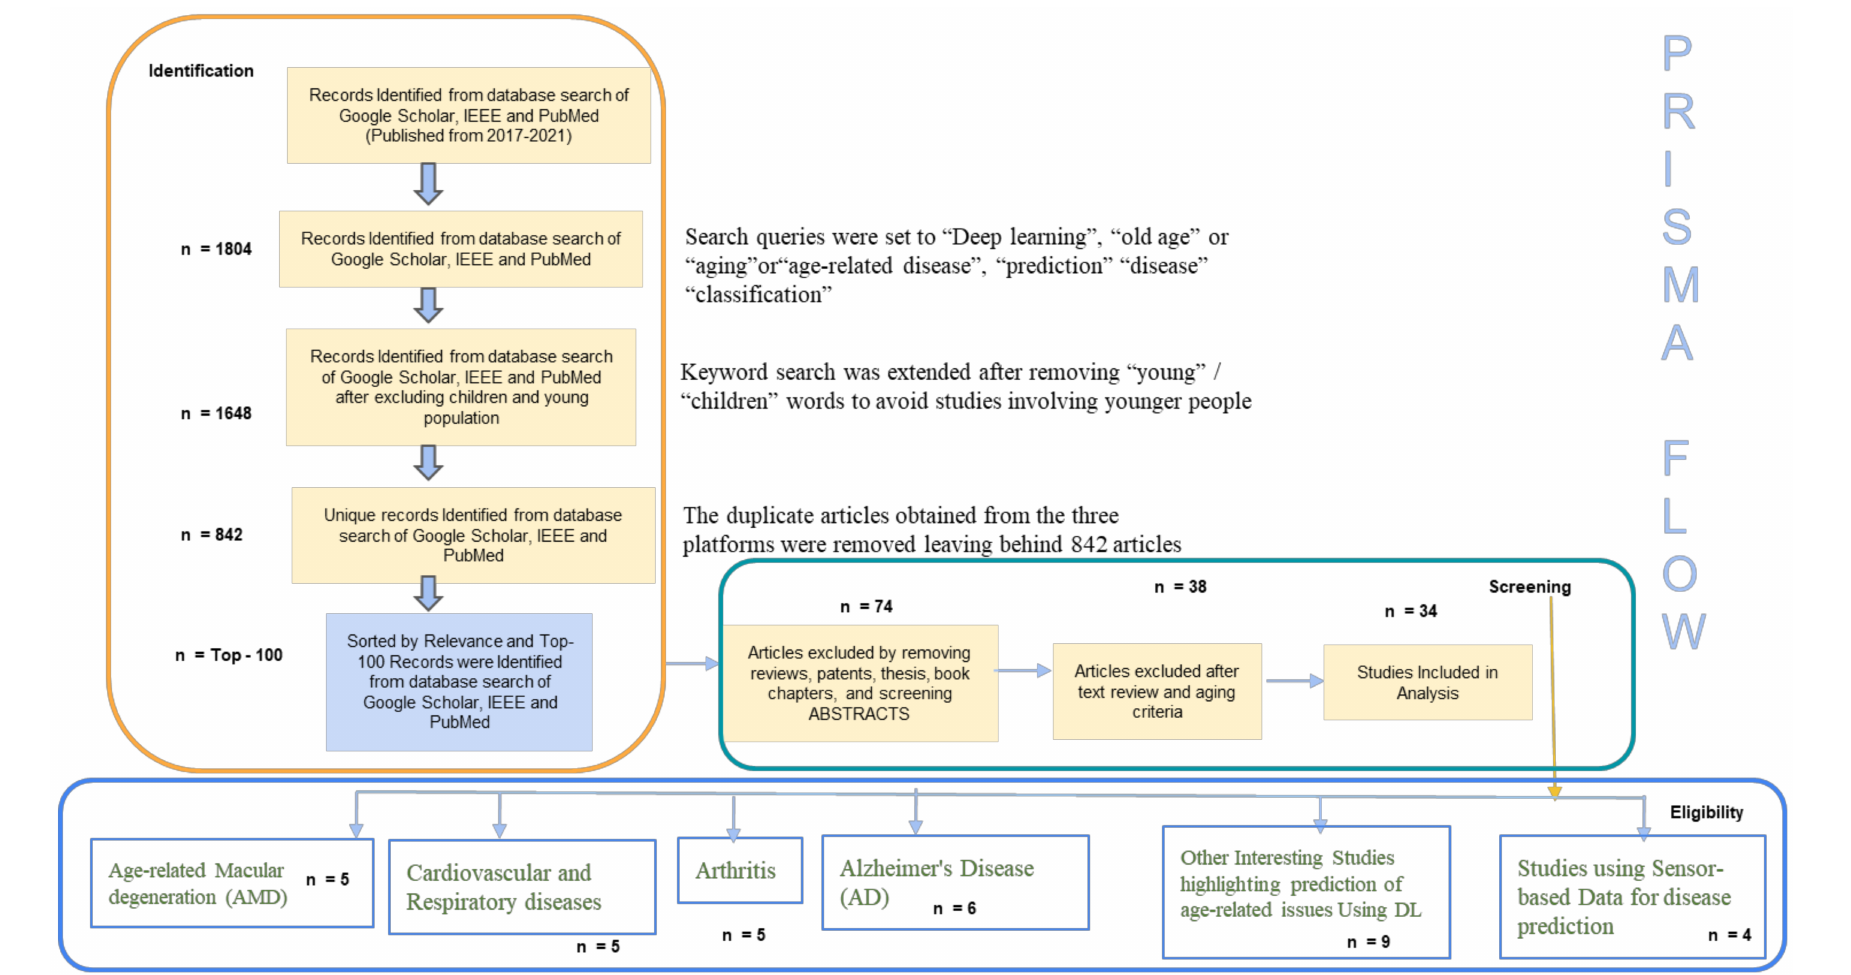
Figure 7. PRISMA flow for the current Scoping